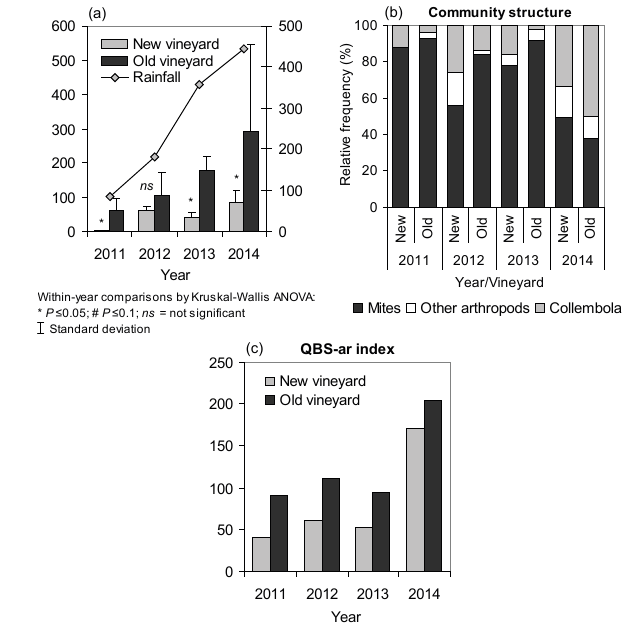
Figure 7. Abundance and community structure of soil microarthro- pods and soil biological quality index (QBS-ar) in the new and old vineyard over the experimental period. The annual abundance is shown together with the cumulative rainfall from January to April (before